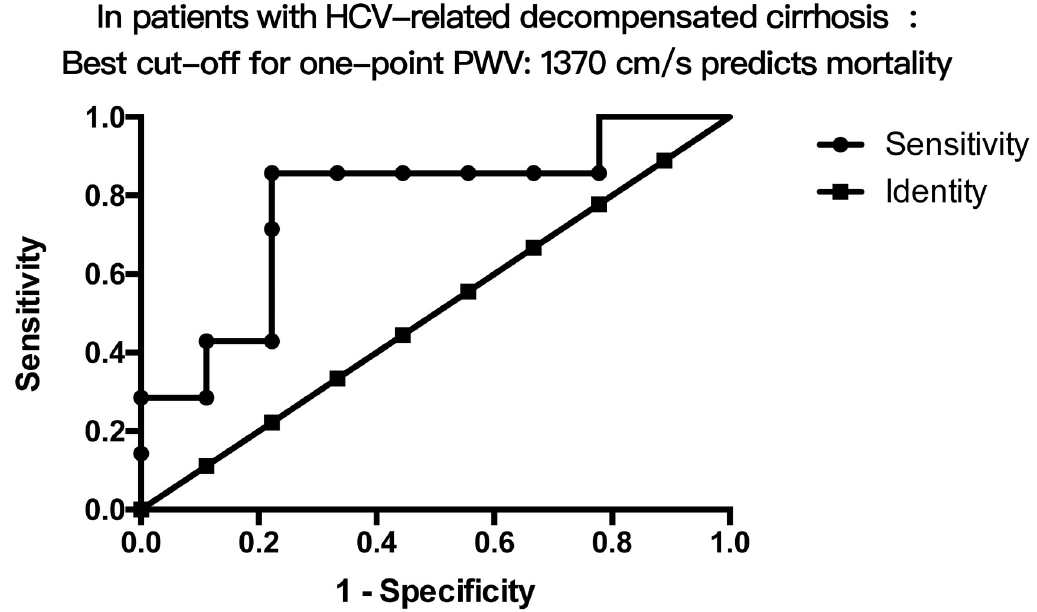
Fig 1. The AUC of one-point PWV in predicting mortalities in patients with HCV related decompensated cirrhosis. By Youden’s index to determine the best cut-off value (highest value of sensitivity+specificity-1), one-point of PWV > 1370 cm/s was the best cut-off value in predicting mortalities for HCV related decompensated cirrhosis (AUROC = 0.813, p = 0.034).